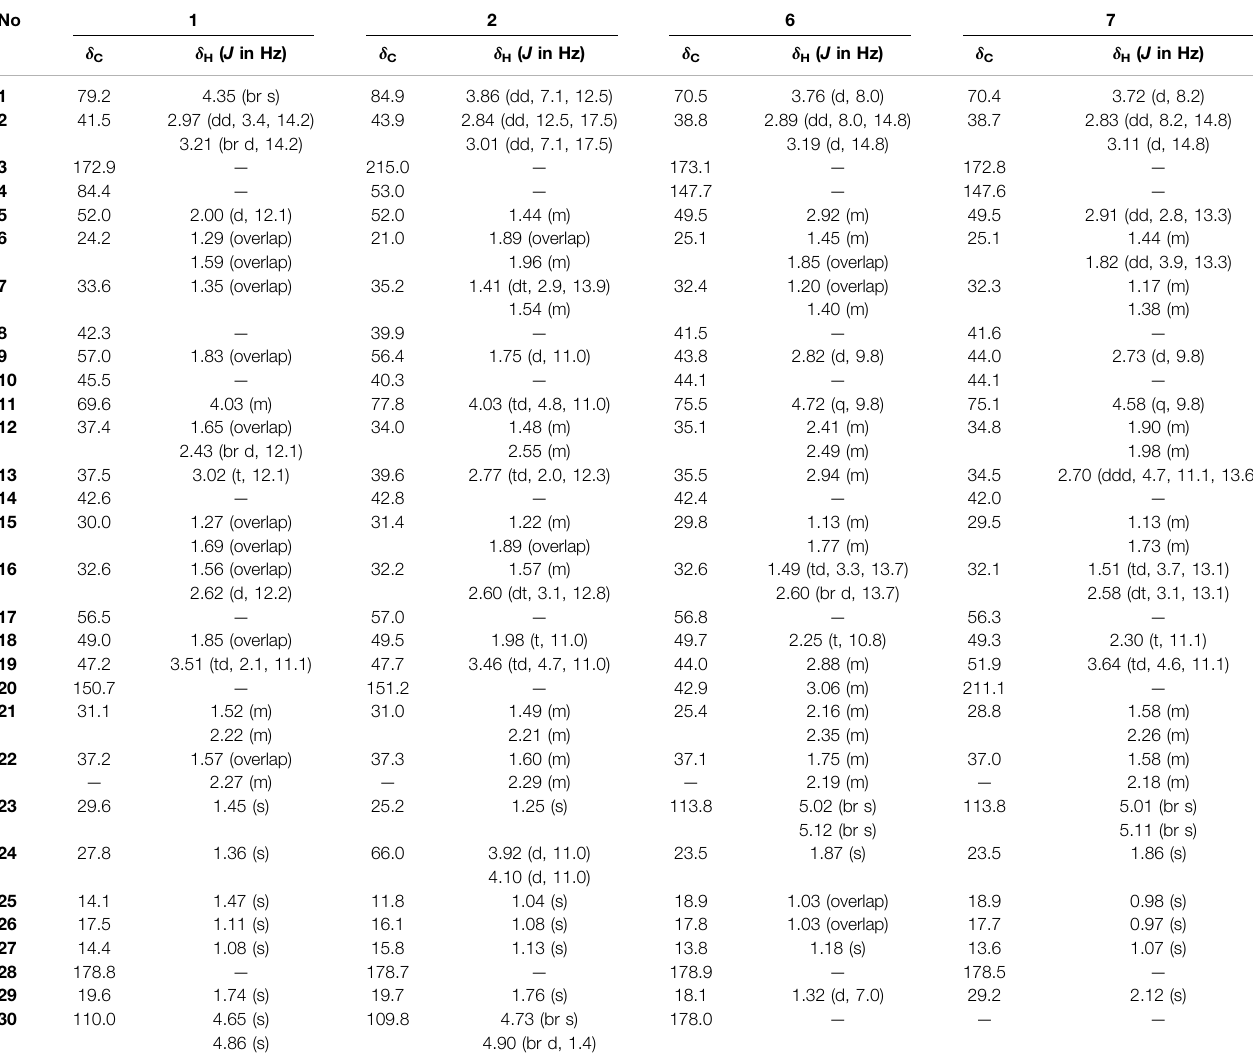
TABLE 1 | 1 H (600 MHz) and 13 C NMR (150 MHz) data in pyridine- d 5 for 1 – 2 and 6 – 7